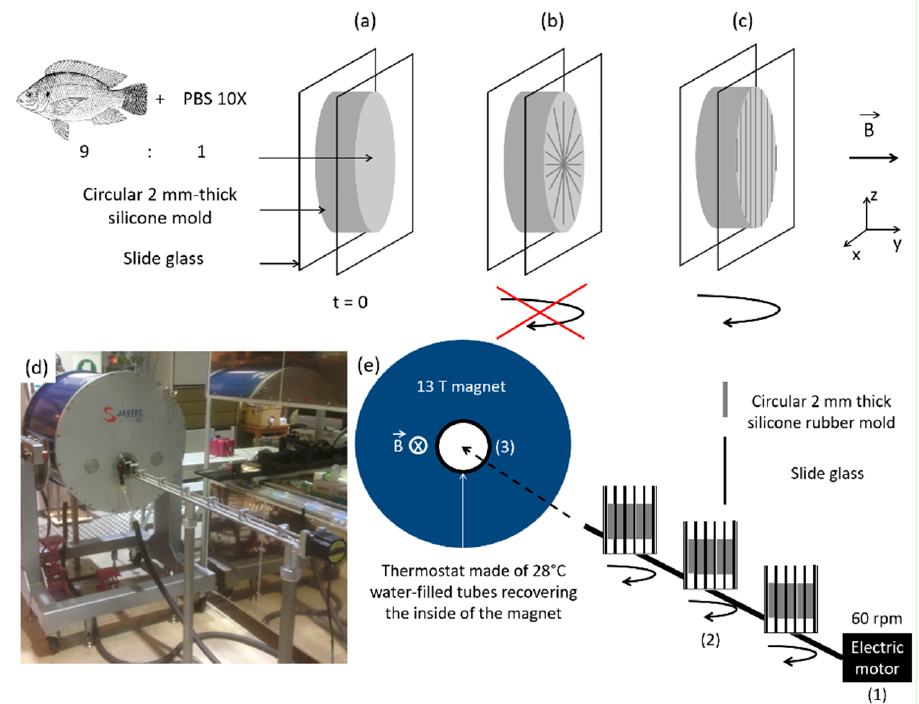
Figure 2. ( a ) Magnetic field application in a collagen gel. ( b ) Under a high magnetic field along y axis and without rotation, collagen fibers perpendicularly align against magnetic field (xz plan). ( c ) Upon rotation, only fibrils along the axis of rotation (z axis) remain. ( d ) Photo of the set-up, and ( e ) scheme of the essential characteristics: electric motor for stirring samples, magnetic field and ther ‐ mostat.